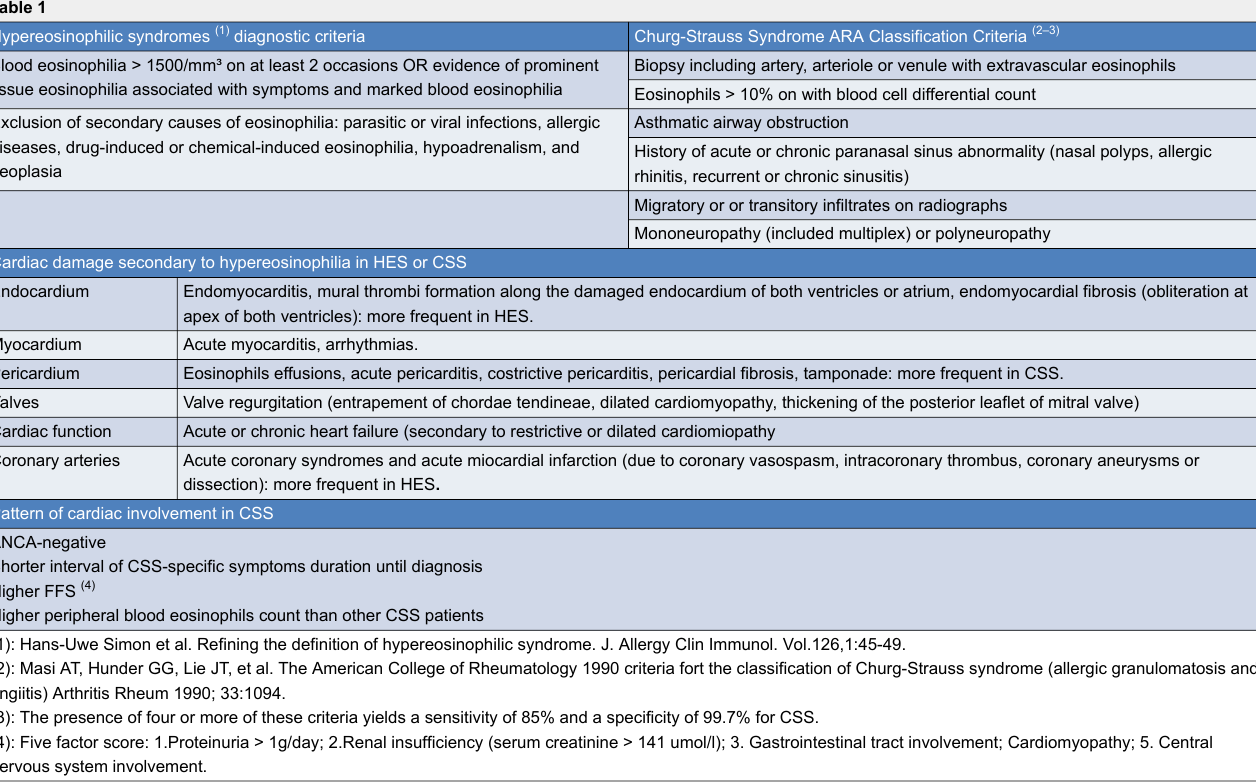
Hypereosinophilic syndromes (1) diagnostic criteria Churg-Strauss Syndrome ARA Classification Criteria